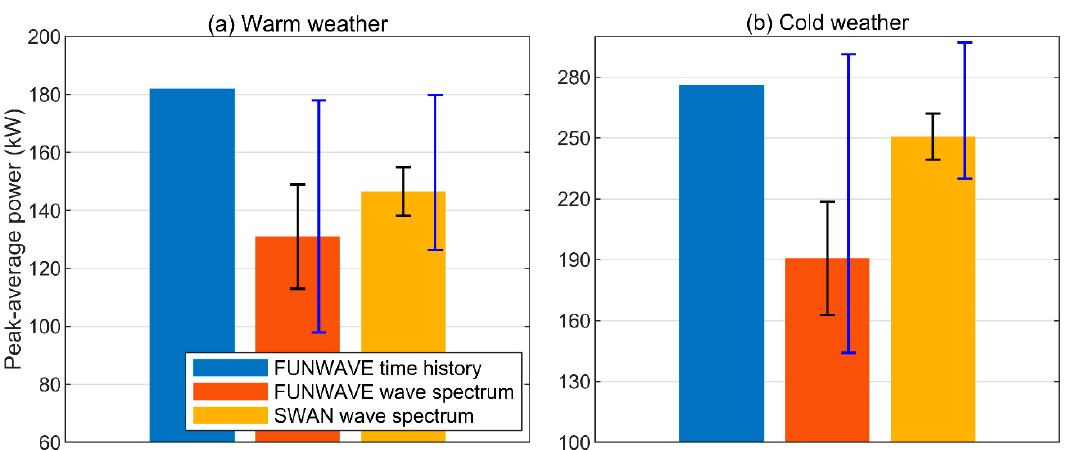
Figure 13. The peak-average power of the WEC farm including all 14 WECs in ( a ) warm weather and ( b ) cold weather months. The column bars are colored by the type of input used in the WEC-Sim simulations. Black error bar: 95% CI; blue error bar: minimum to maximum value range.